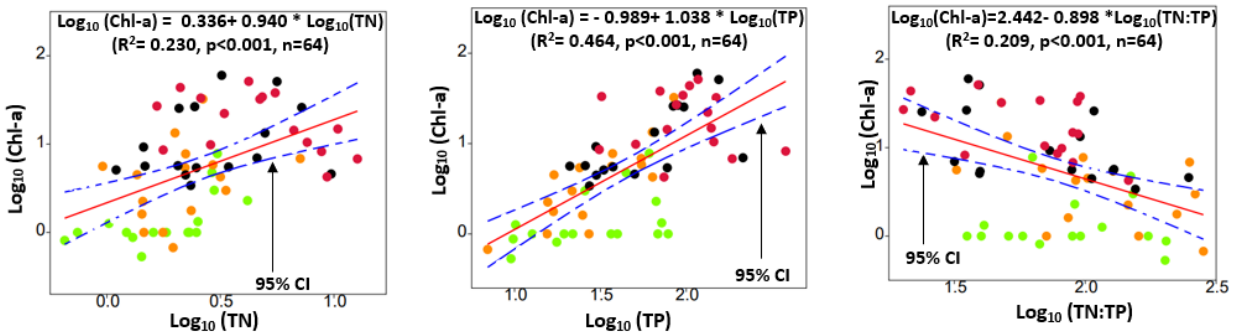
Figure 5. Linear regression analysis of the primary productivity indicator Chl-a with relation to water nutrient parameter (TN, TP) and their ambient ratios (TN:TP) in each of the four land-use patterns (green: forest region, orange: agriculture region, black: urban upstream region, red: urban downstream region).